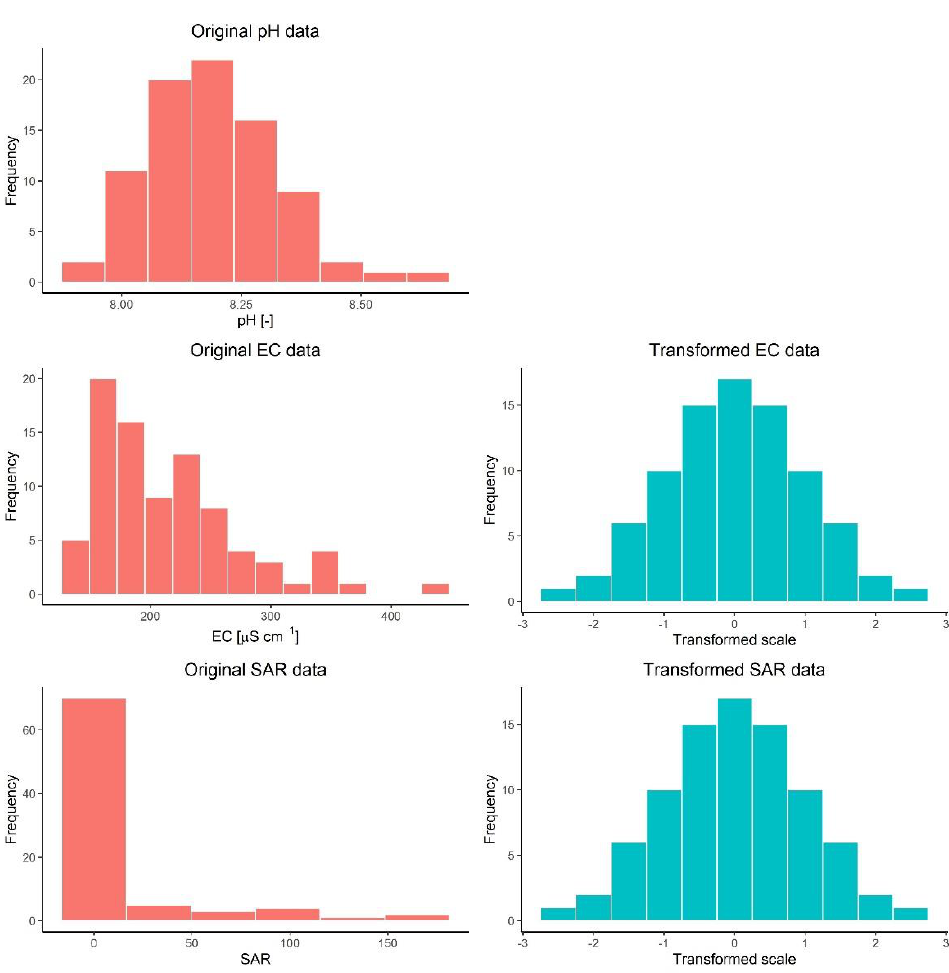
Figure 3. Histograms of the indicators of salt-affected soils before ( left column ) and after ( right column ) transformation. Legend: Abbreviations: EC: electrical conductivity and SAR: sodium adsorption ratio.